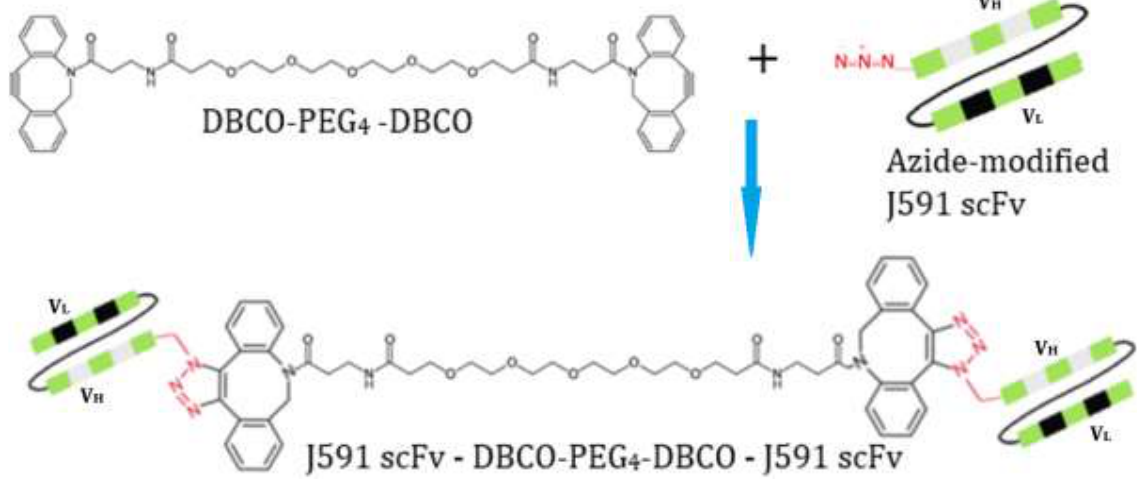
Figure 5. Copper-free click chemistry reaction of J591 scFv-pAzF and DBCO-PEG linker under physiological